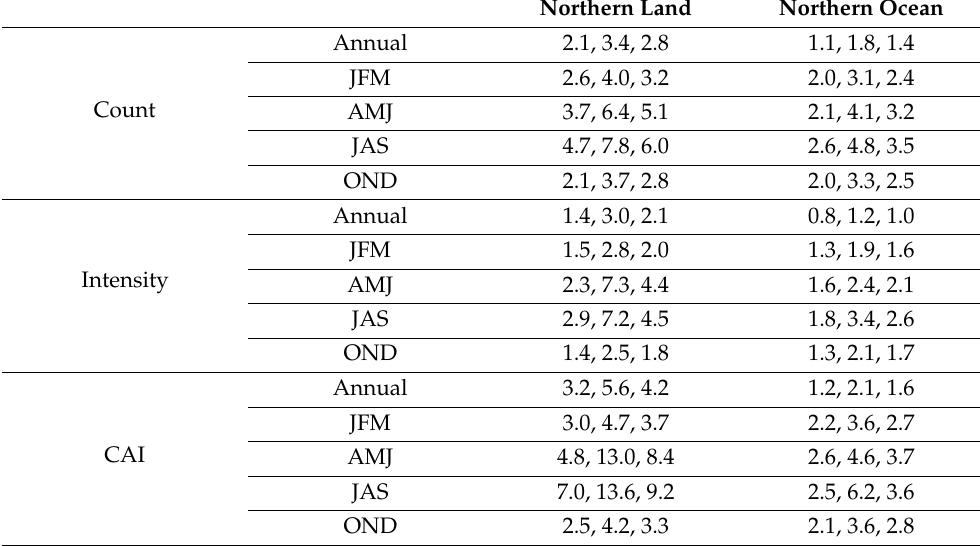
Figure 3. Time series of the annual mean cyclone count (per 250 km grid-box; ( top panels )), intensity (10 −5 hPa km −2 ; ( middle panels )), and CAI (10 −5 hPa km −2 per 10 6 km 2 ; ( bottom panels )) over the northern extratropical land ( left panels ) and ocean ( right panels ). The horizontal axis is the year. Results of the ensemble mean (relatively smooth black curve within the grey shading) and ensemble standard deviation (grey shading) are given for 20CRv3 over the period 1951 – 2015. Results from ERAint (magenta curve) and ERA5 (light blue curve), as well as their average (ERAavg; red curve), over the period 1979 – 2018, are also shown. Table 1. Statistics related to the ratios (%) of ensemble spread to the ensemble average of the cyclone indices from the 80 members in 20CRv3. Three numbers in each cell, in turn, indicate the minimum, maximum, and mean ratios over the 65 years from 1951 to 2015. Results include the annual and seasonal ratios over the northern extratropical land and ocean.